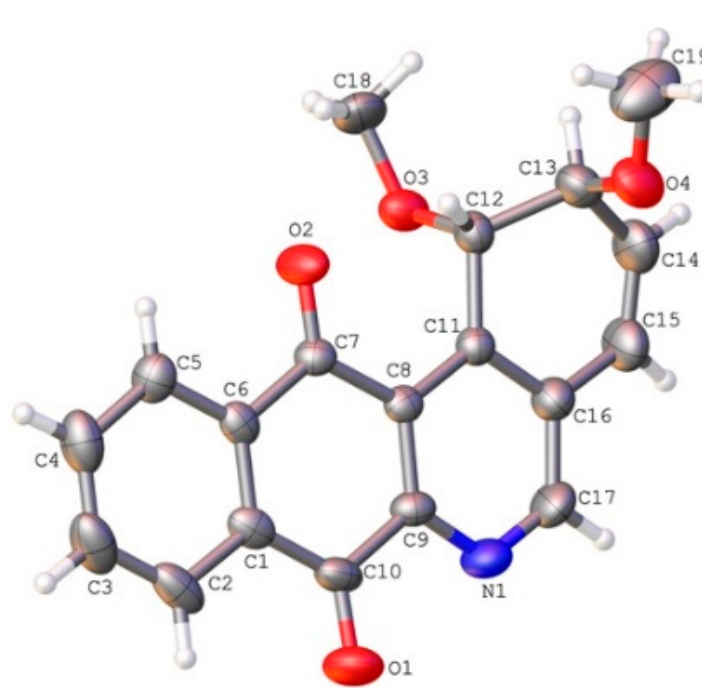
Figure 4. Molecular structure of compound 19c . Thermal ellipsoids are shown with 30% probability.